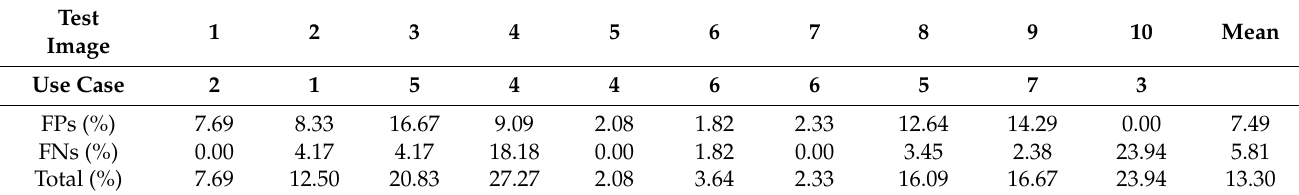
Table 5. Performance evaluation of the RGB model (best performing) applied to the separate test images for each use case, expressed as percentages (%) of false positives, false negatives, and their sum